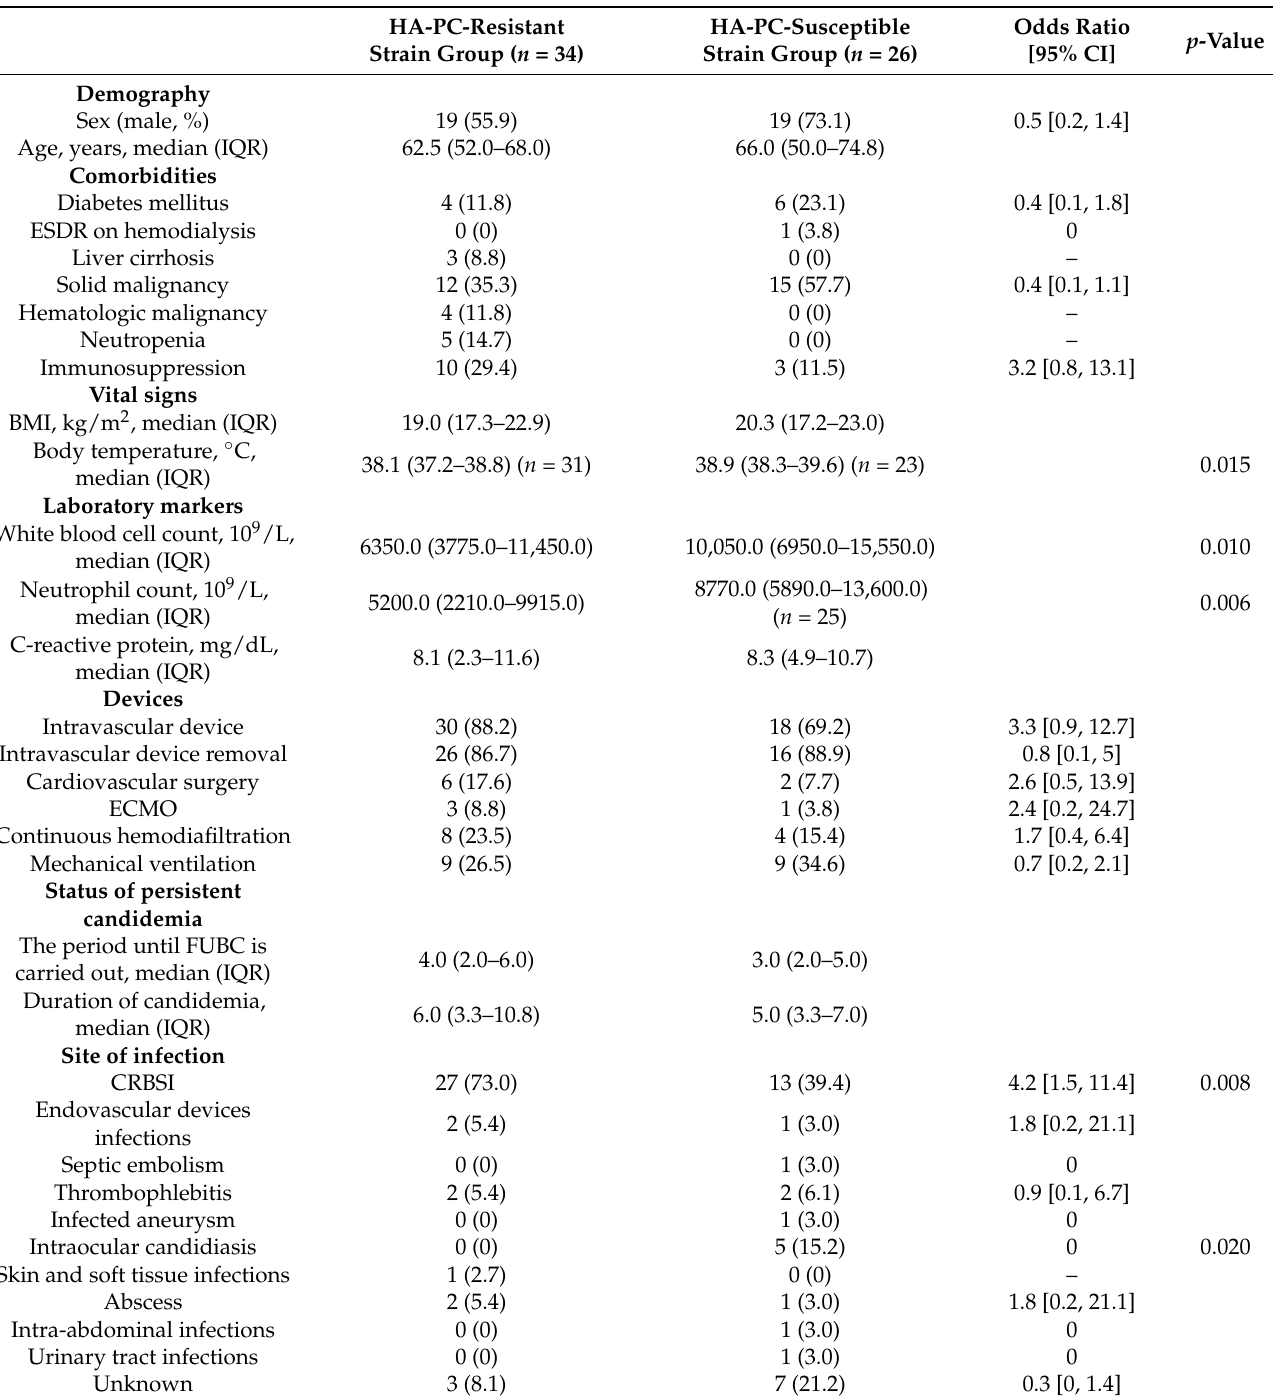
Table 2. Clinical characteristics of hospital-acquired persistent candidemia in terms of azole or echinocandin